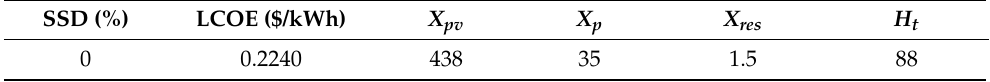
Table 2. Optimized parameter values corresponding to the optimal best solution.